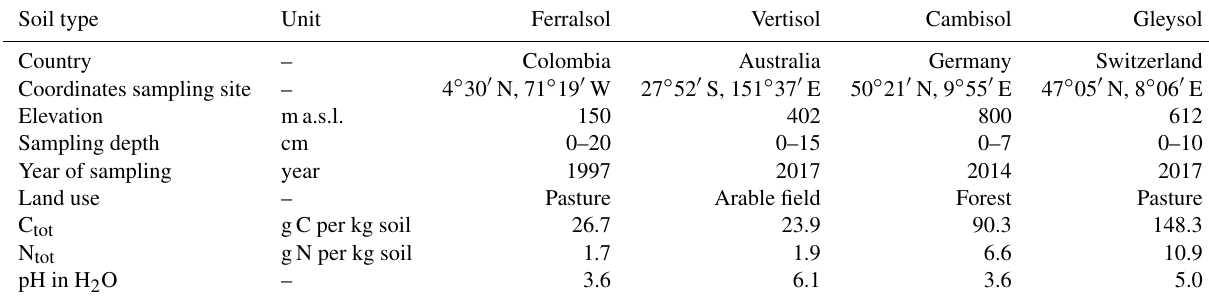
Table 1. General characteristics of soil samples used in this study. Soil